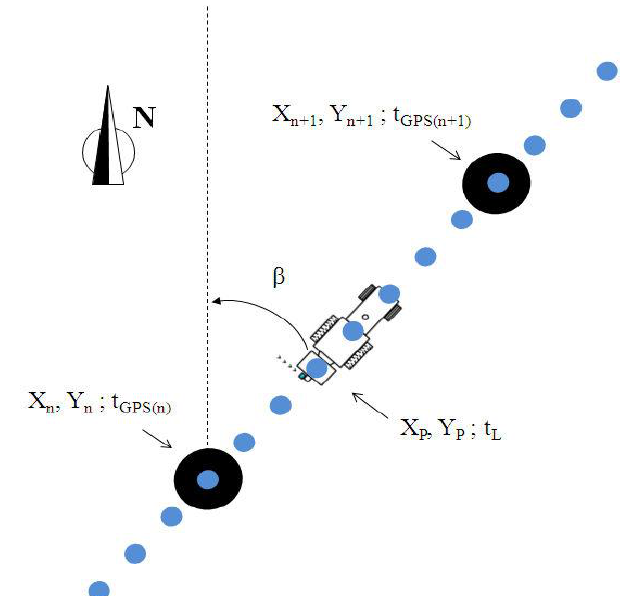
Figure 5. Procedure for determining the UTM coordinates of each LiDAR measurement